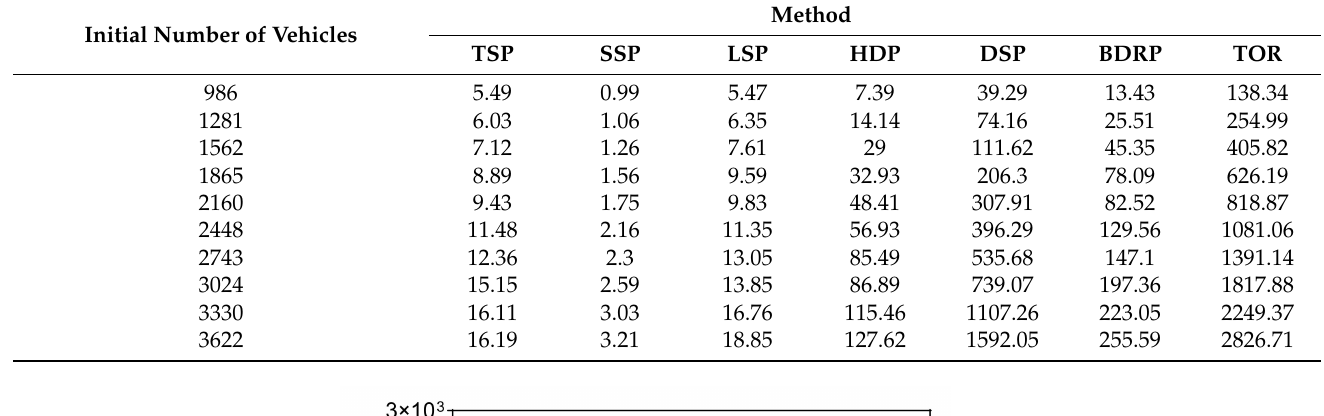
Table 2. Relationship between the number of vehicles and the algorithm running time (s).